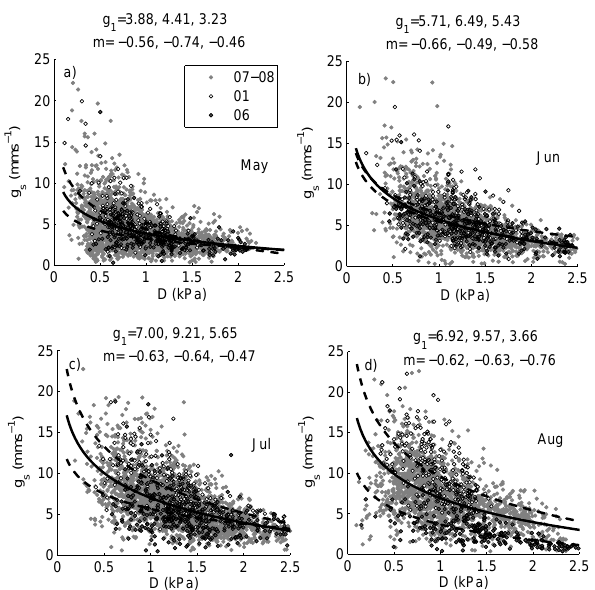
Fig. 8. Sensitivity of surface conductance ( g s ) to vapor pressure deficit ( D ) during May (a) , June (b) , July (c) and August (d) . The model fitted to data is g s = g 1 − m × ln (D) according to Oren et al. (1999) where g 1 represents conductance at 1kPa and m is the sensitivity to D . The parameters g 1 and m are given for each month and years 2007–2008, 2001 and 2006, respectively.